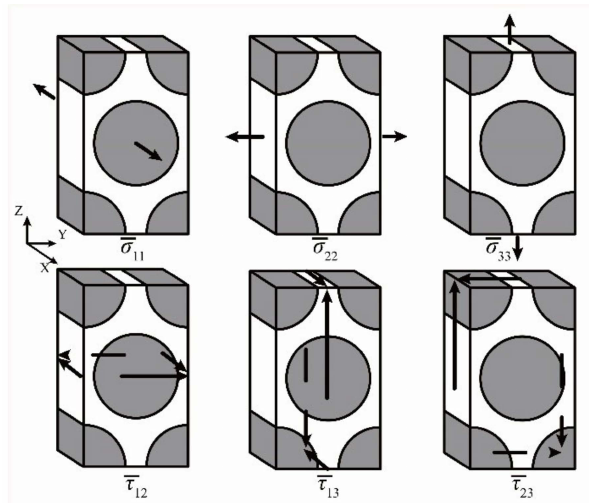
Figure 2. Macro-scale stresses applied on the micro-scale RUC in obtaining stress amplification factors (SAFs) of M